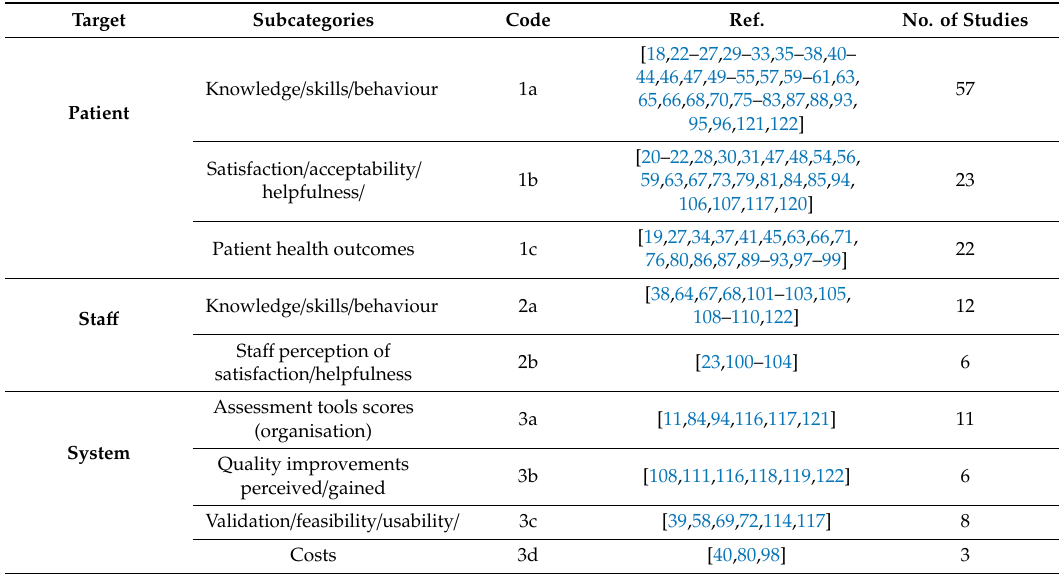
Table 4. Outcomes (see supplementary file for more